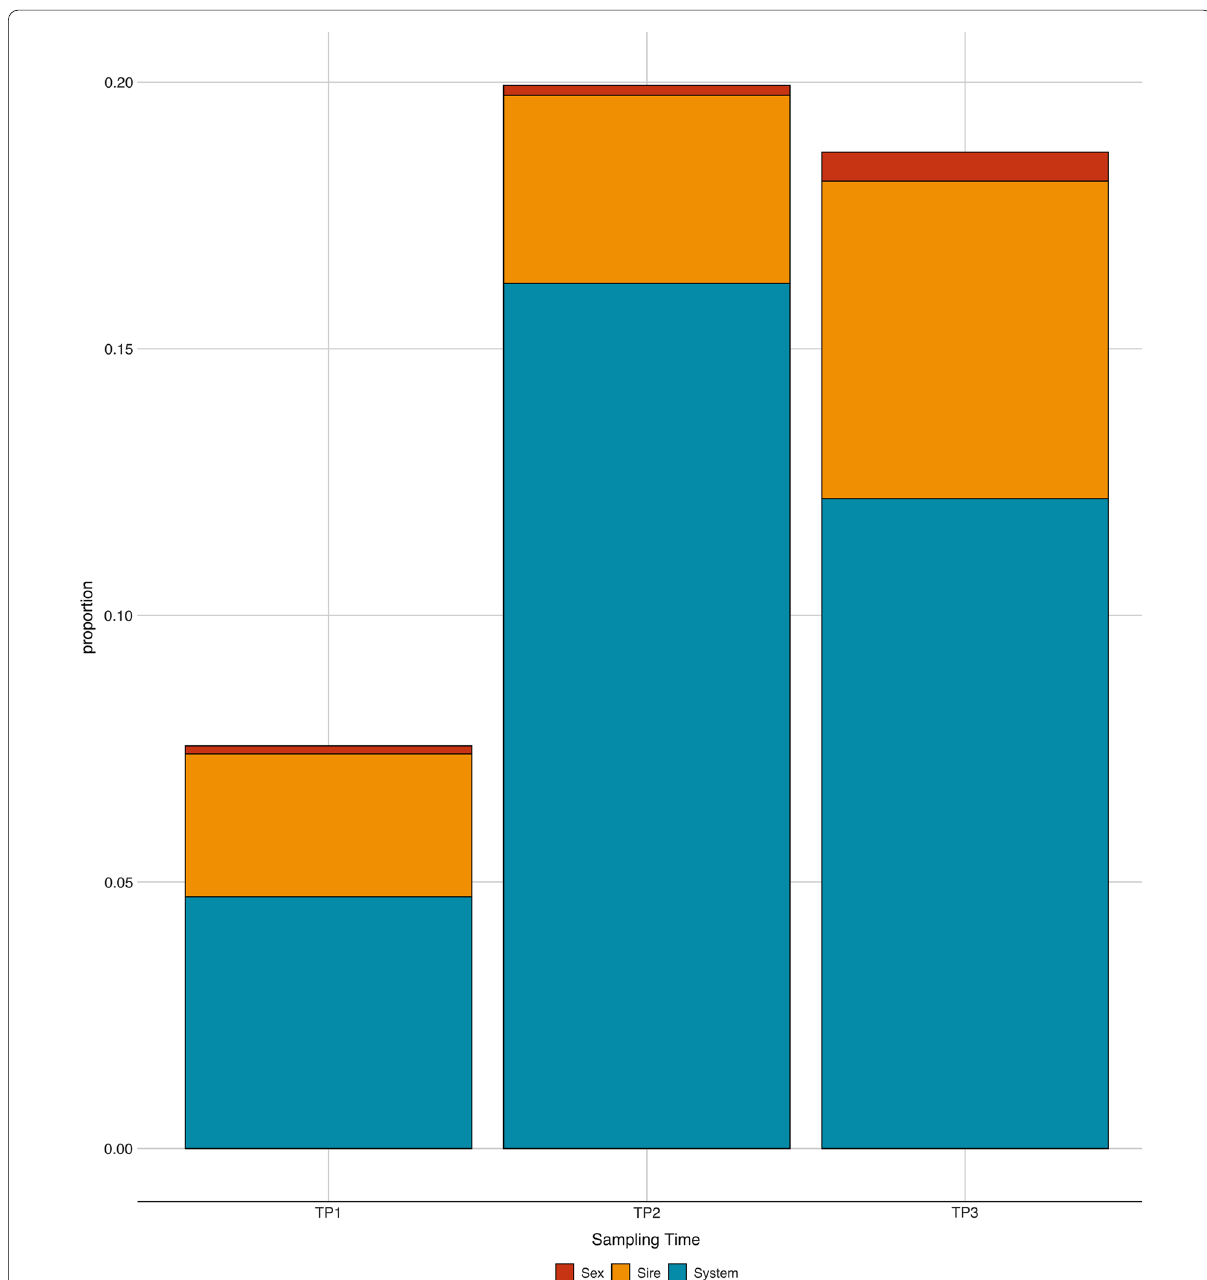
Fig. 4 The contribution to the total R2 of each effect in the model. Permanova R 2 contribution of each effect to the overall model for Purebred (NU) and Crossbred (TE) at three time points: weaning (TP1), mid test (TP2), and off test (TP3) of the feeding